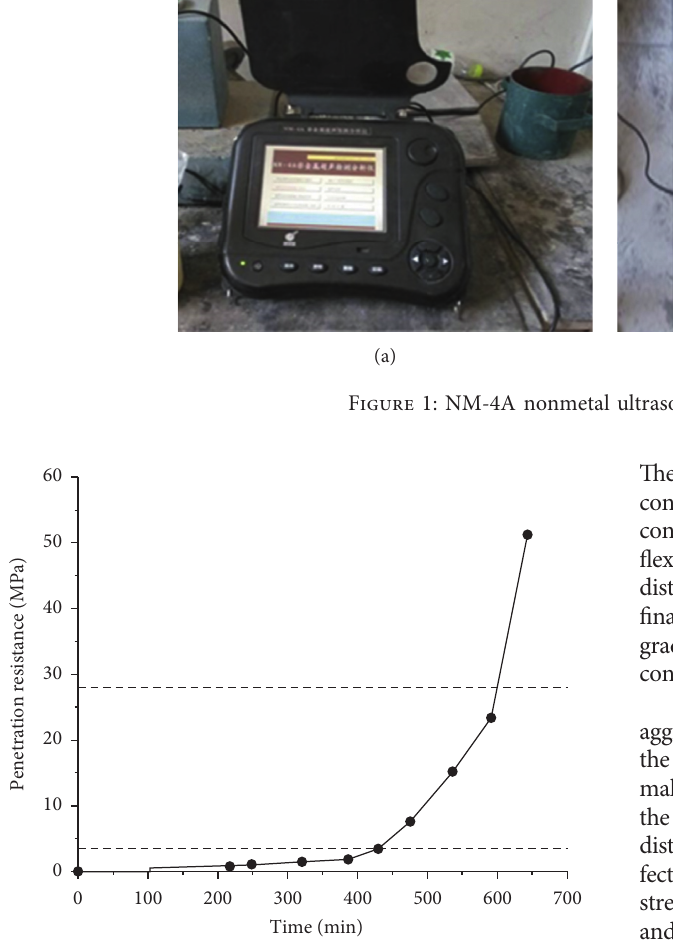
Figure 2: Curve of penetration